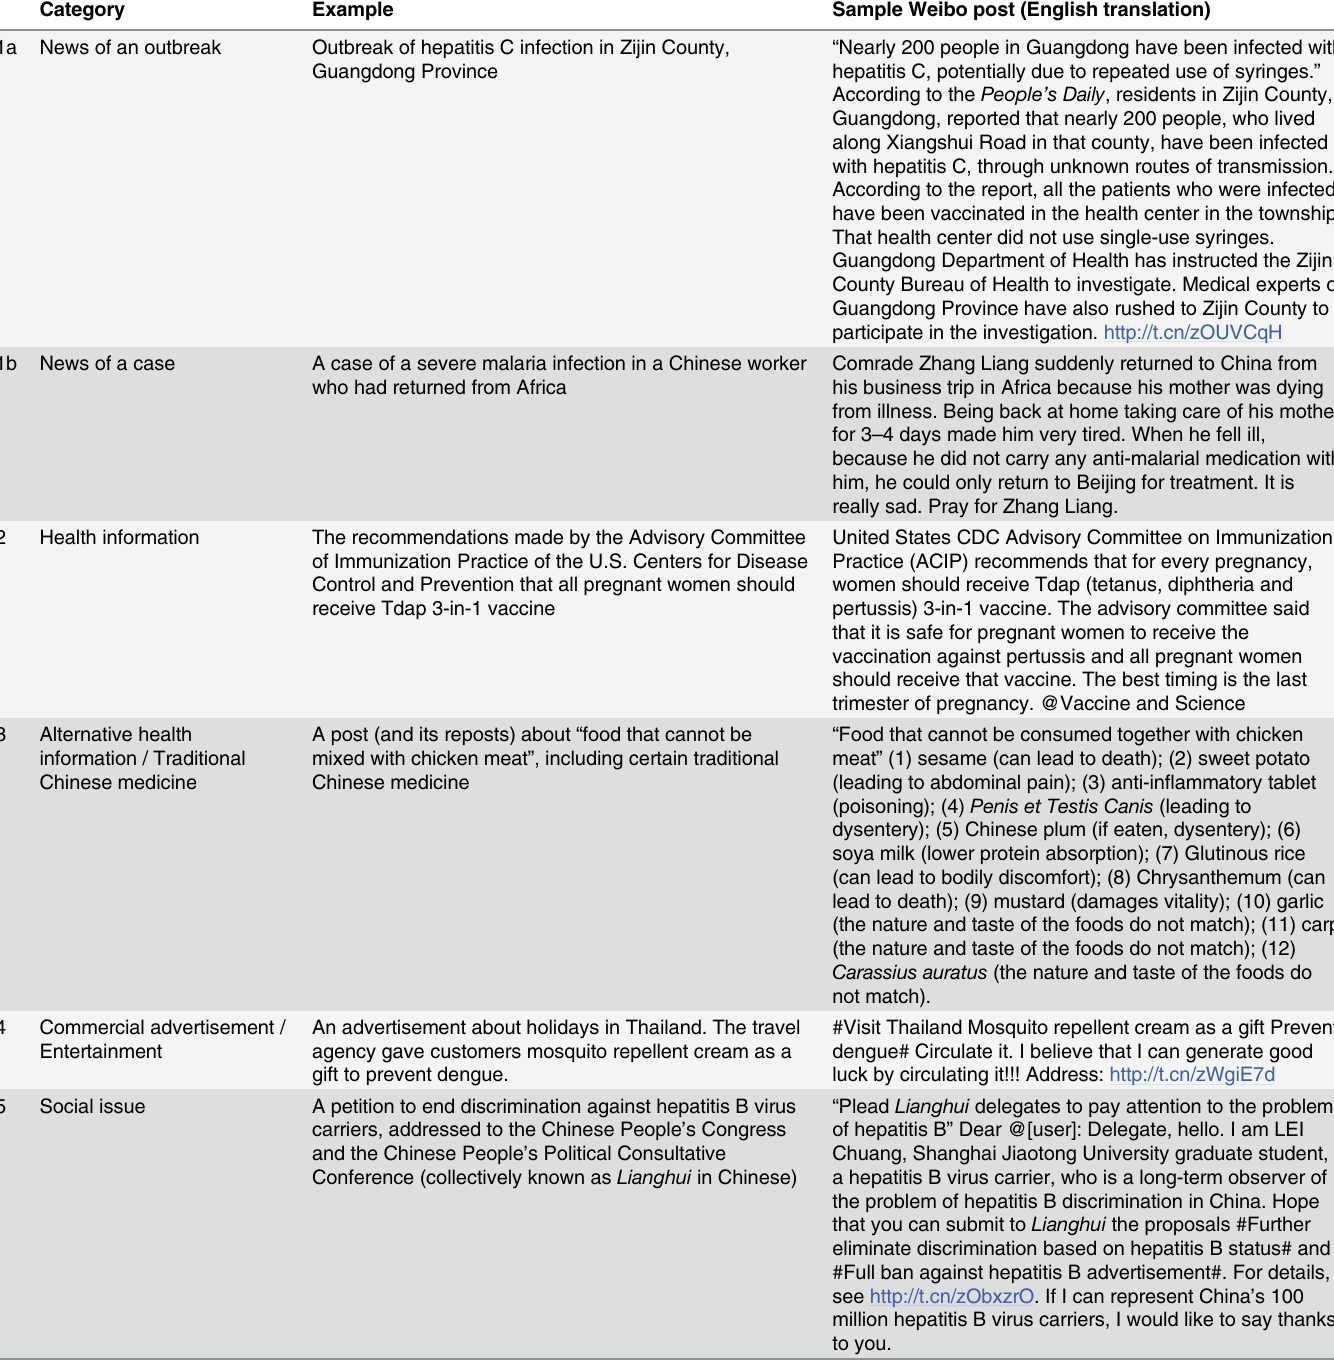
Table 3. Categories and examples of Weibo posts that led to a peak in Weibo traffic as found in the WeiboScope database (January 1 to December 31, 2012).